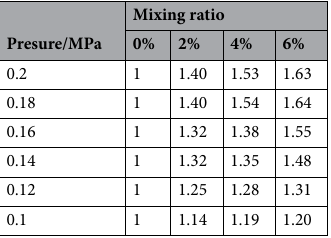
Table 2. PDIV ratio of C 6 F 12 O mixed gas to pure N 2